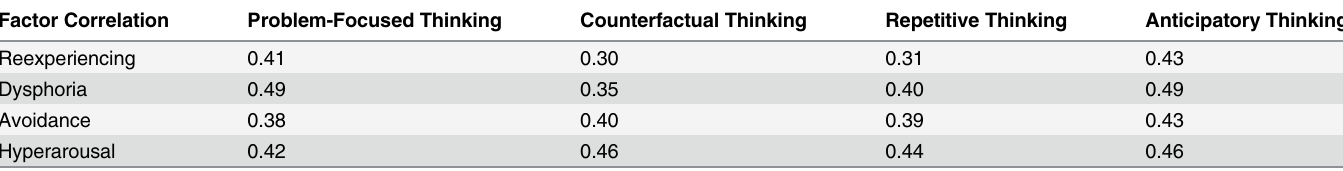
Table 6. Factor Correlations for the Combined Dysphoria Model of PTSD and Four-Factor Rumination Model. Factor Correlation